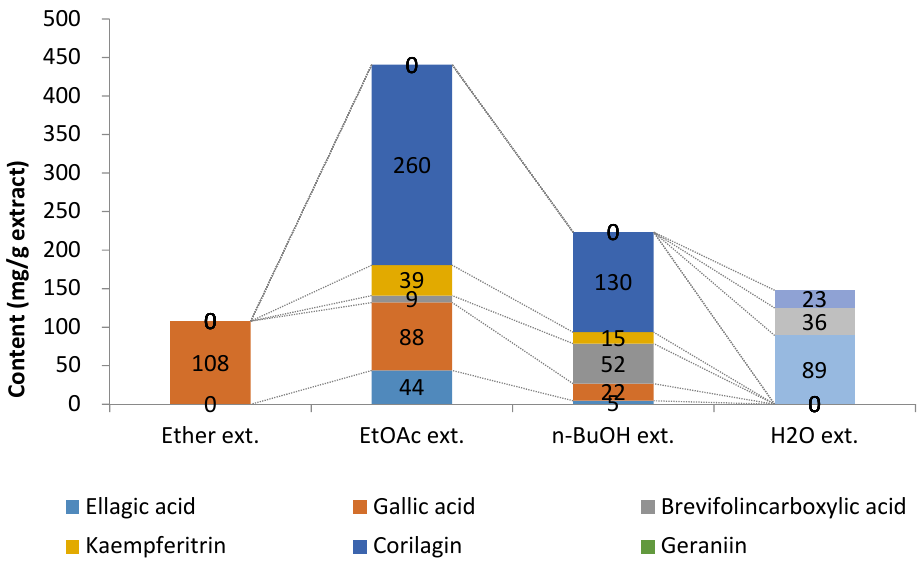
Figure 5. The main polyphenol and organic acid contents in each extract from the long-term decoction of G. thunbergii.